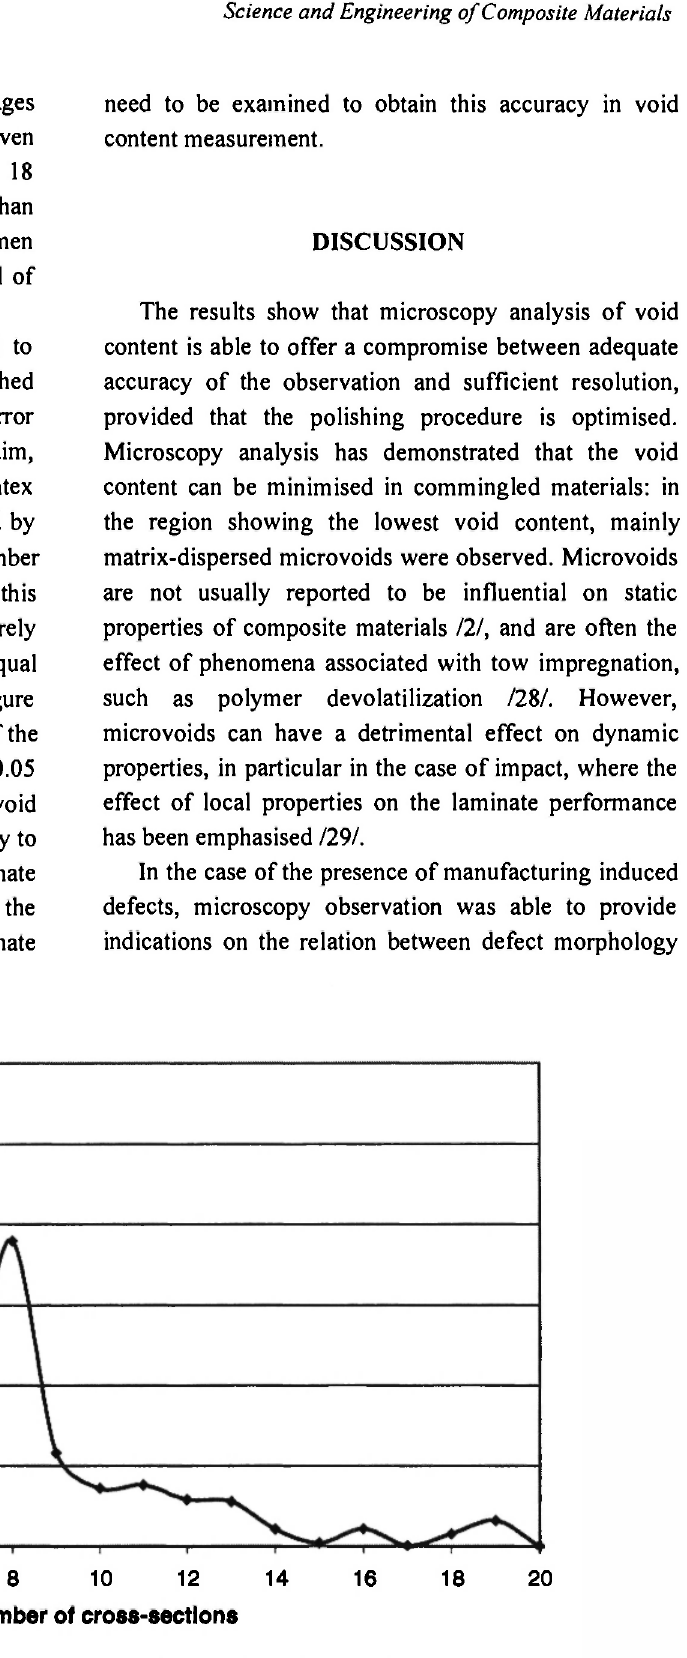
Fig. 10: Error using different numbers of cross-sections from the same